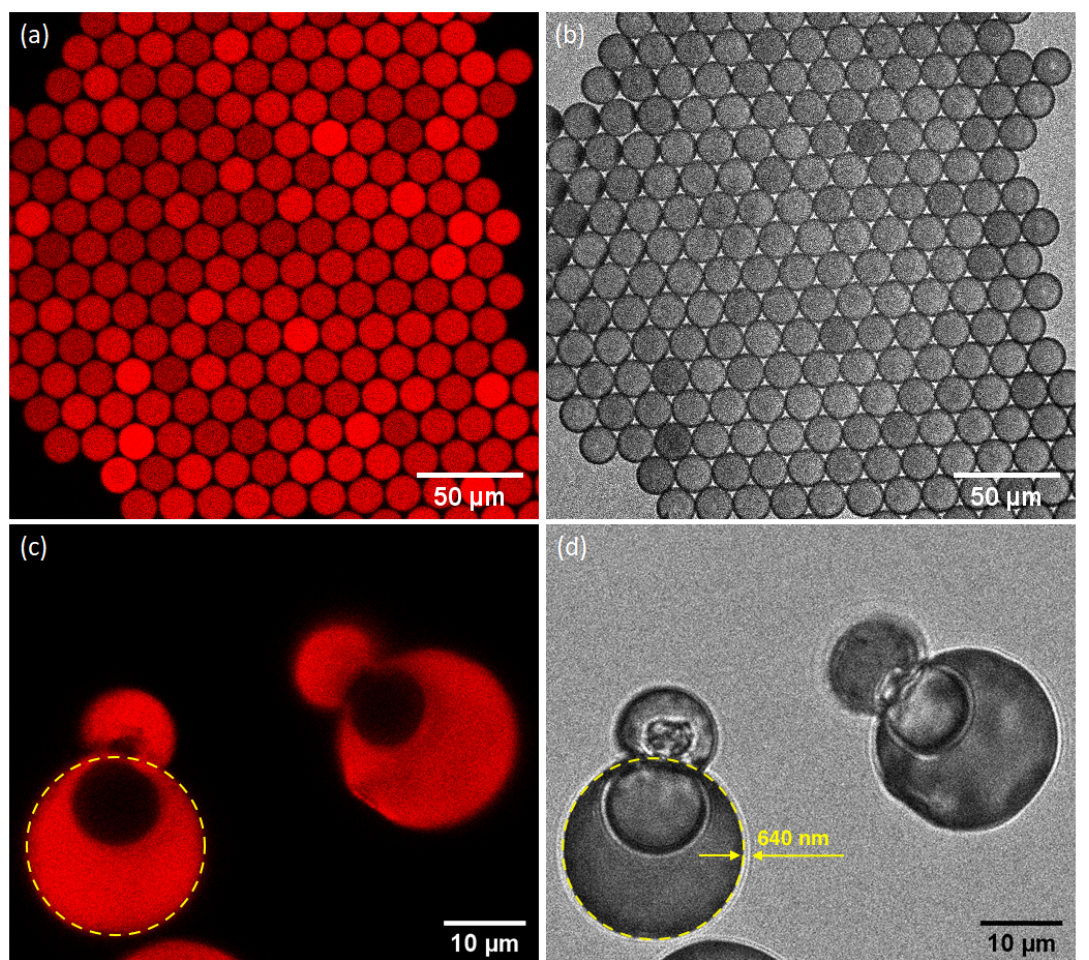
Figure 7. ( a , c ) Confocal fluorescence and ( b , d ) the corresponding white field microscopy images of 16.8 µ m zinc oxide microspheres, ( c , d ) where we can see the top part of the microcapsule